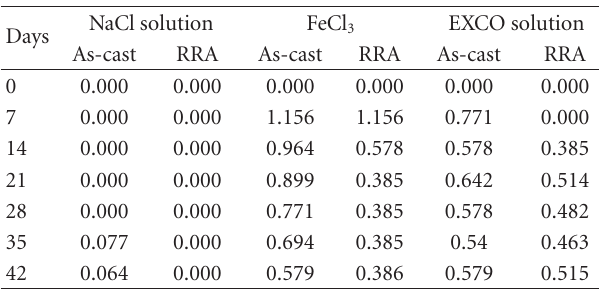
Table 3: Gravimetric corrosion rate (mm/yr) for the 0.91% Mg specimen.